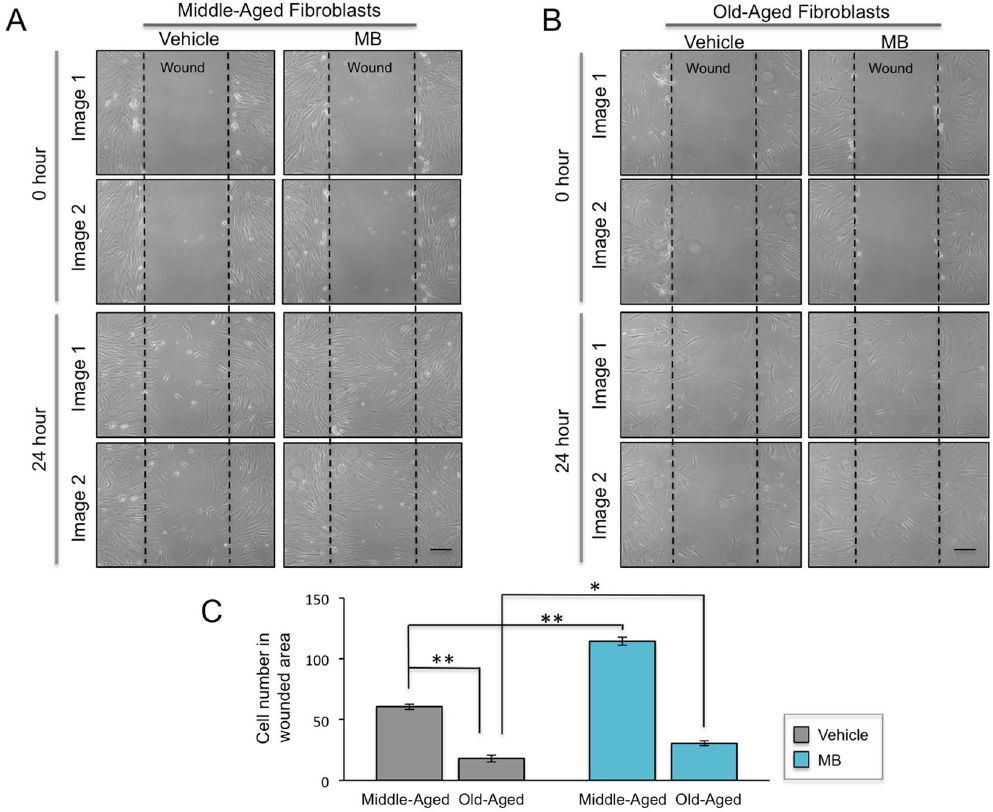
Figure 7. MB promotes wound healing in dermal fibroblasts. ( A , B ) Representative images showing skin fibroblasts migration in the scratch-wounded area at 0 and 24 hours post wound. The cells were pre-treated with Vehicle (PBS) or 100 nM MB for one week. The wound region was then manually created by scrapping a straight line across the cultured cells. Fibroblasts from a middle-aged donor ( A , HGFDFN168, 40 yrs) and an old-aged donor ( B , AG11725, 84 yrs) were tested. Scale bar = 200 μ m. ( C ) Quantification of the cell number in each wounded region at 24 hours post wound. ( * p < 0.05, ** p <